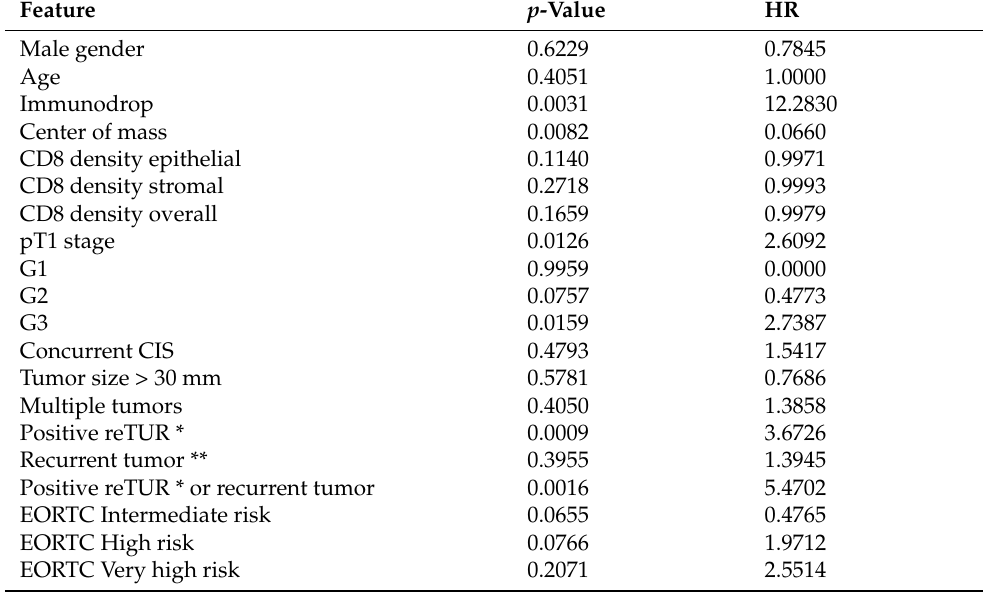
Table 2. Univariable Cox regression